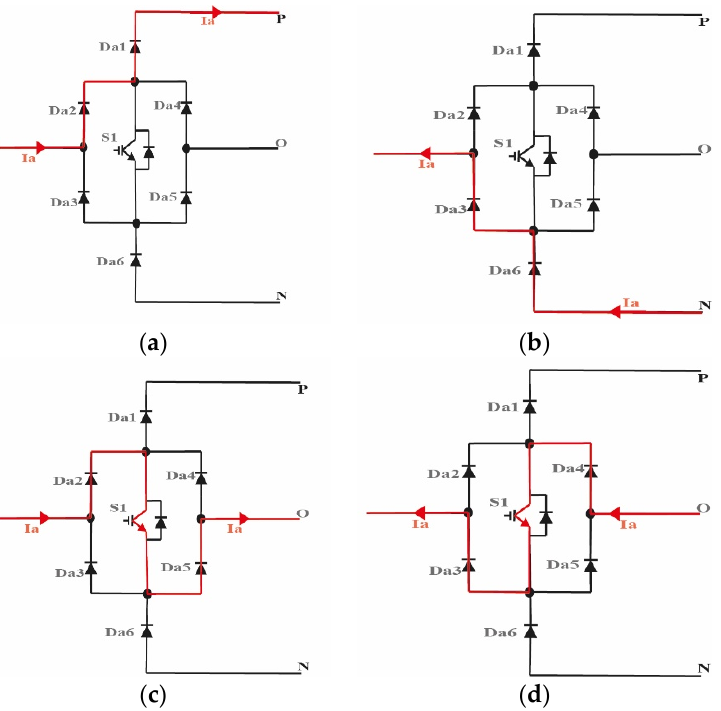
Figure 4. Vienna rectifier operation principle. ( a ) When S1 is OFF and Ia > 0 ( b ) When S1 is OFF and Ia < 0 ( c ) When S1 is ON and Ia > 0 ( d ) When S1 is ON and Ia <